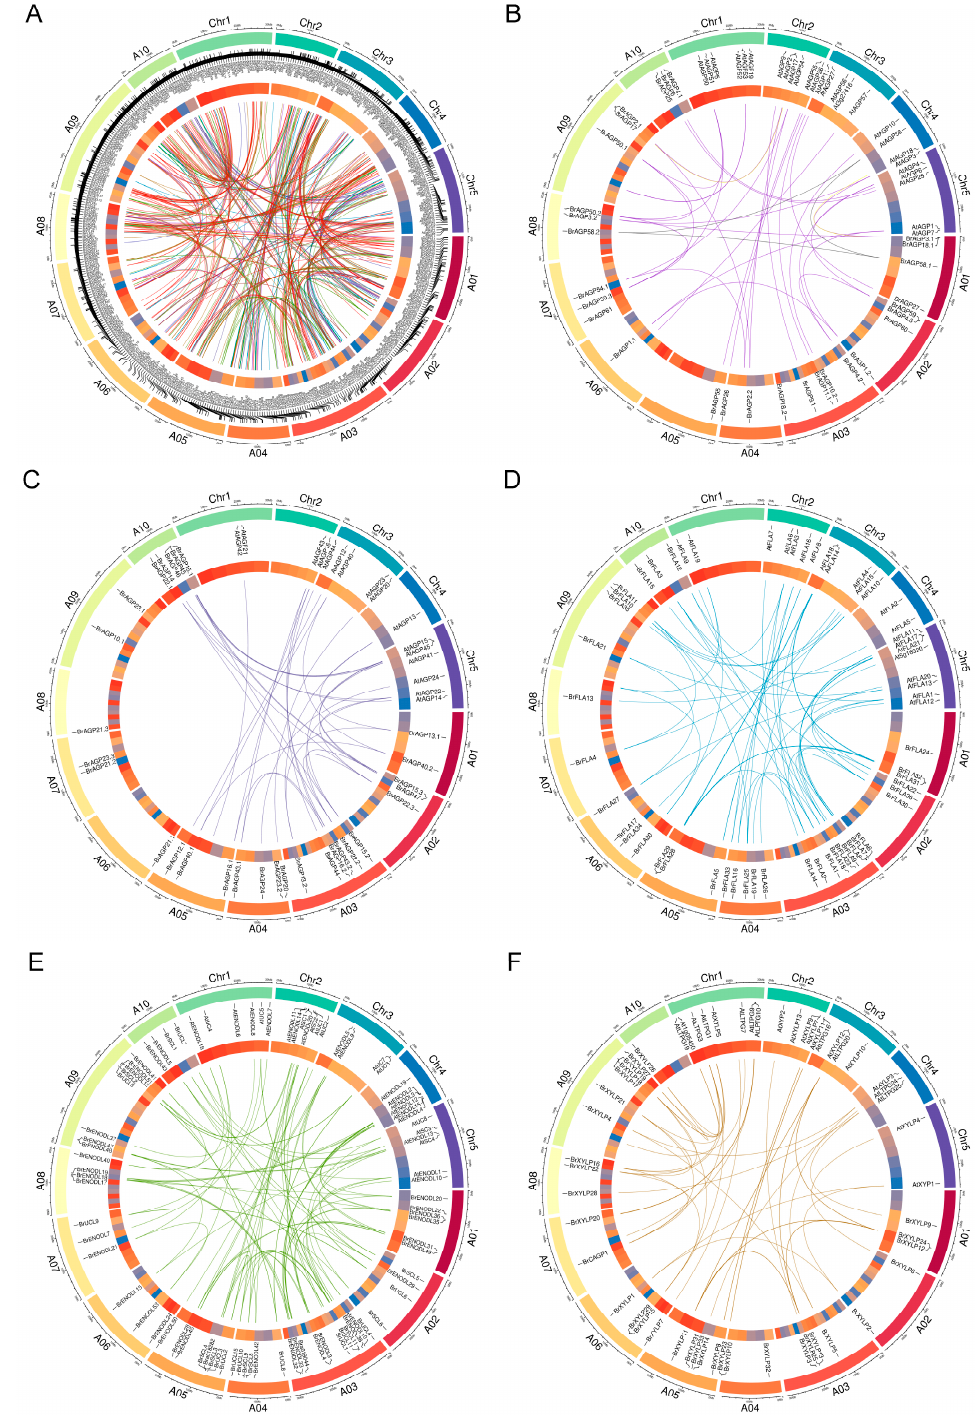
Figure 3. Circos plots showing AGP genes on chromosomes of the Arabidopsis genome and the Brassica rapa genome. ( A ) All AGPs. ( B ) Classical AGPs and Lys-rich AGPs. ( C ) AG-peptides. ( D ) Fasciclin-like AGPs (FLAs). ( E ) Phytocyanin-like AGPs (PLAs). ( F ) Xylogen-like proteins (XYLPs). From the outside in, the first layer of the Circos plot is a chromosome map of the Arabidopsis genome and the B. rapa genome. The 24 conserved collinear blocks on the ten chromosomes of the B. rapa genome and the five chromosomes of the Arabidopsis genome were color coded in the second circle. The network in the center of the plot represents the syntenic relationships between BrAGPs and AtAGPs according to the syntenic gene search in the Brassica database. Classical AGPs were linked in dark violet lines, Lys-rich AGPs in yellow lines, non-classical AGPs in gray lines, AG-peptides in dark slate blue lines, FLAs in dodger blue lines, PLAs in green lines, XYLPs in sandy brown lines, other chimeric AGPs (CAGPs) in red lines and AGP/extensin hybrids (HAEs) in navy blue